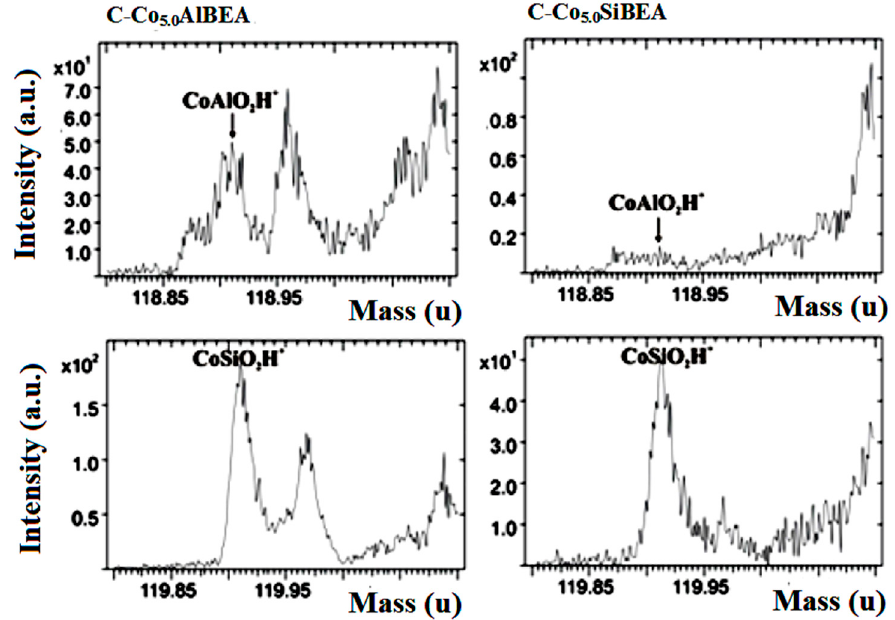
Figure 4. ToF-SIMS spectra of CoAlO 2 H + and CoSiO 2 H + ions collected for C-Co 5.0 AlBEA and C-Co 5.0 SiBEA.